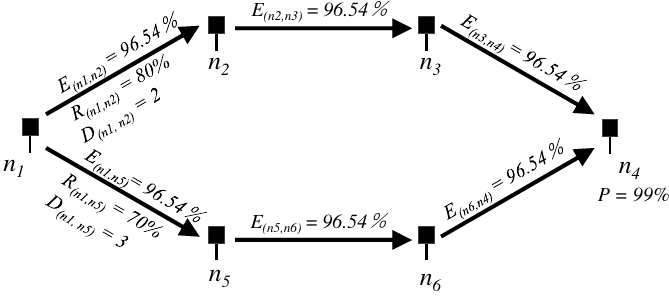
Figure 7. Example of ADP in MP-RDV: When two relays are available, nodes such as n 1 expect the same delivery ratio on both paths and computes the number of duplicated packets on each of